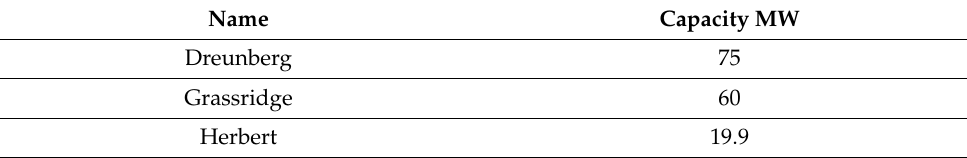
Table 3. Solar PV installation in Eastern